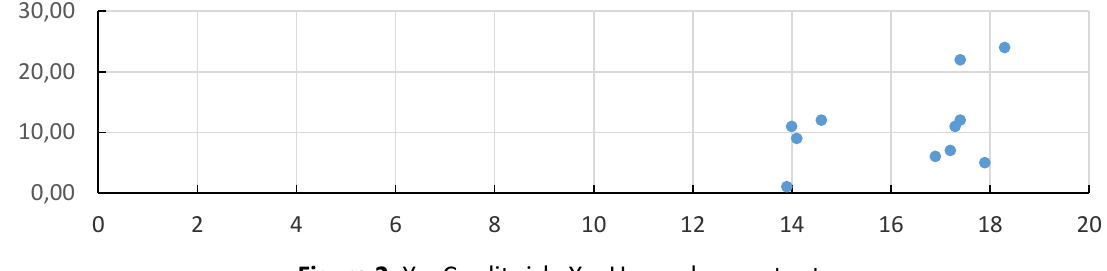
Figure 2. Y – Credit risk, X – Unemployment rate